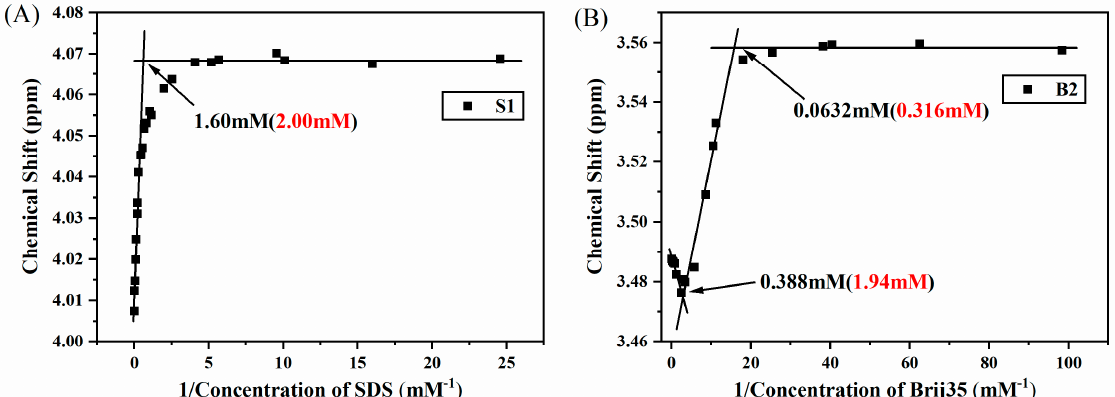
Figure 3. For α SDS = 0.8, variations of chemical shift of the resonance S1 from SDS ( A ) and B2 from Brij35 ( B ) as a function of reciprocals of their concentrations. The intersection of the fitted lines indicates the CMC, the corresponding C T is shown in red font.